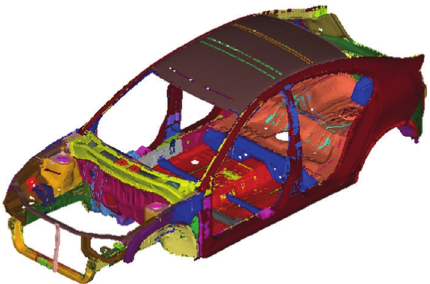
Figure 1: Original BIW